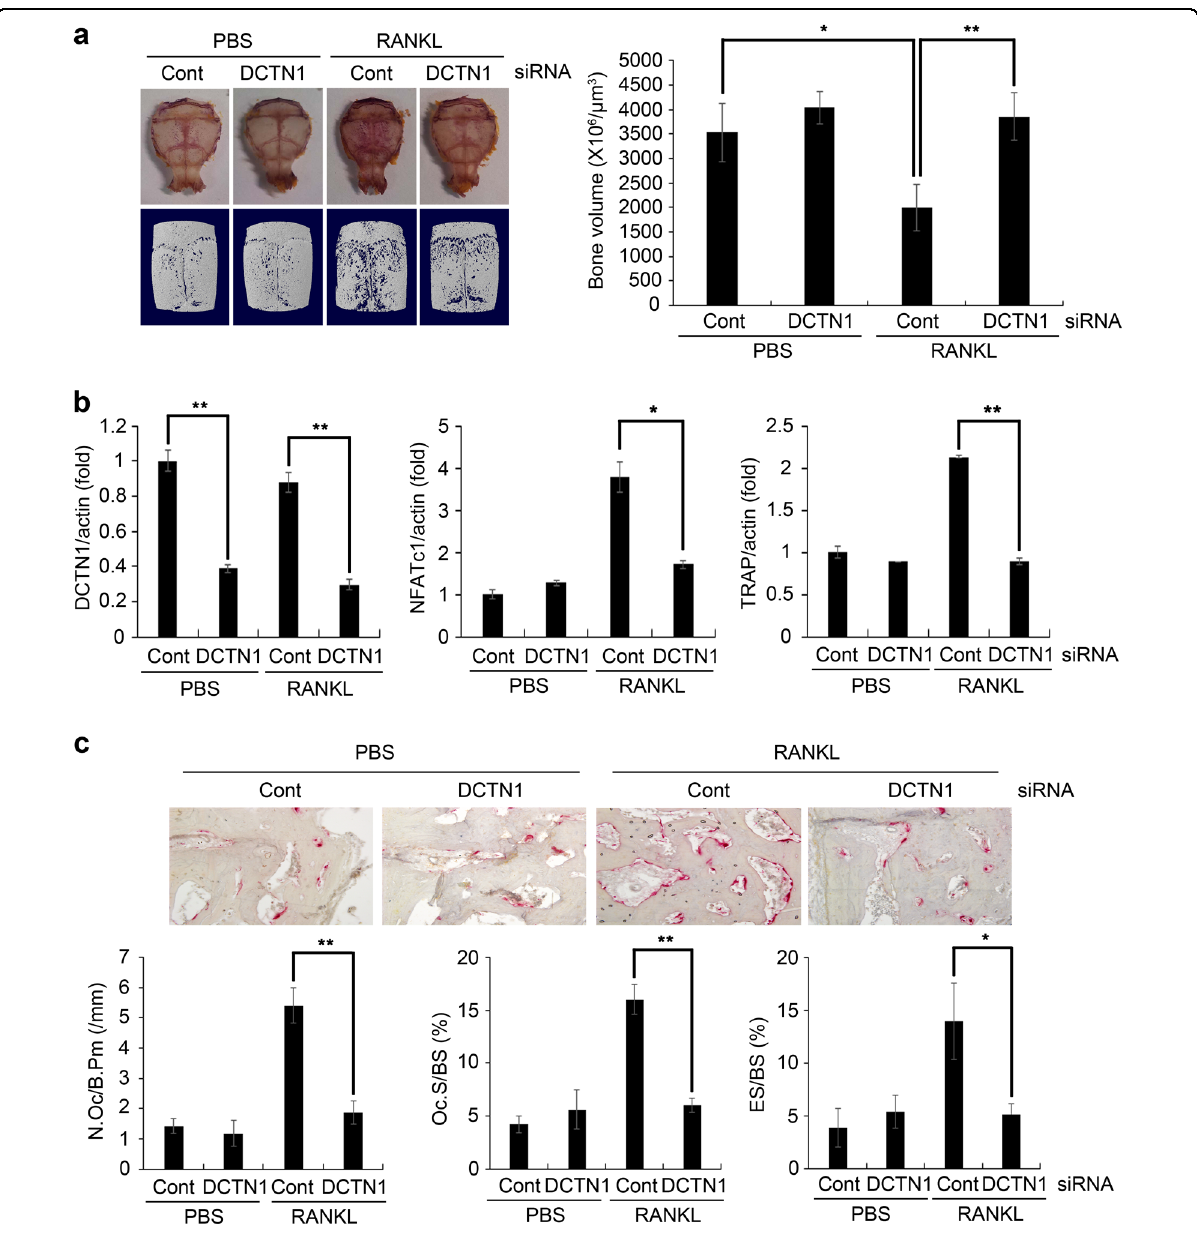
Fig. 6 DCTN1 silencing decreases osteoclastogenesis in vivo. Control or DCTN1 siRNA mixed with transfection reagents was injected into the calvariae of 5-week-old mice, and then a collagen sheet soaked with PBS or RANKL was implanted. On day 7, the mice were sacri fi ced. a Mouse calvariae were stained for TRAP (upper panel). The calvariae were also subjected to μ CT analysis, and 3D images are shown (lower panel). Quantitative values of calvarial bone volume are shown in a histogram (right panel). b DCTN1, NFATc1, and TRAP mRNA levels in calvarial tissue were analyzed by real-time PCR. c Sections of calvariae were stained for TRAP activity. Representative images of stained sections are shown. Quantitative analysis of the sections included the following parameters: OC number/bone perimeter (N.Oc/B.Pm); OC surface/bone surface (Oc.S/BS); and eroded surface/bone surface (ES/BS). n = 5 per group. * p < 0.05, ** p < 0.005 compared with PBS